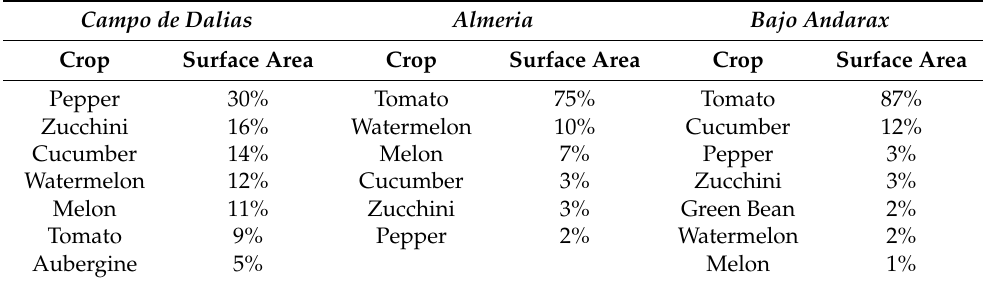
Table 2. Crop distribution in each of the study areas.